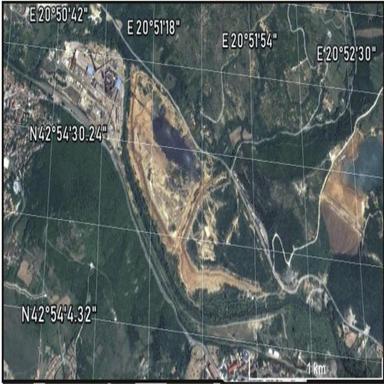
Location of the Gornje Polje Research Area.